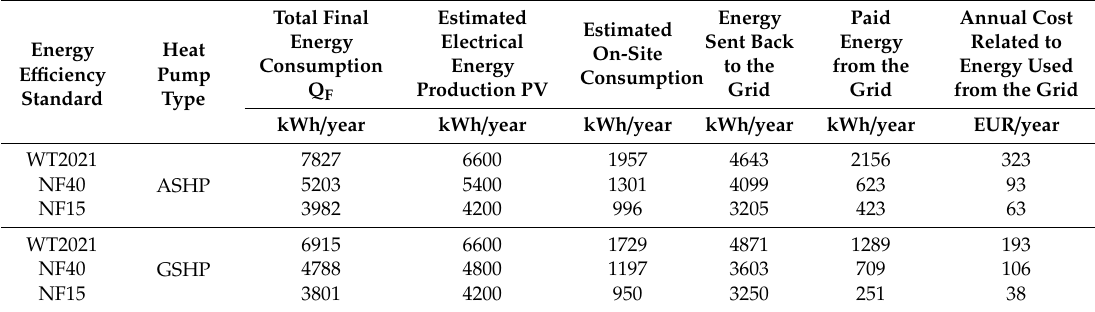
Table 19. Calculation of annual cost related to the energy used from the electrical